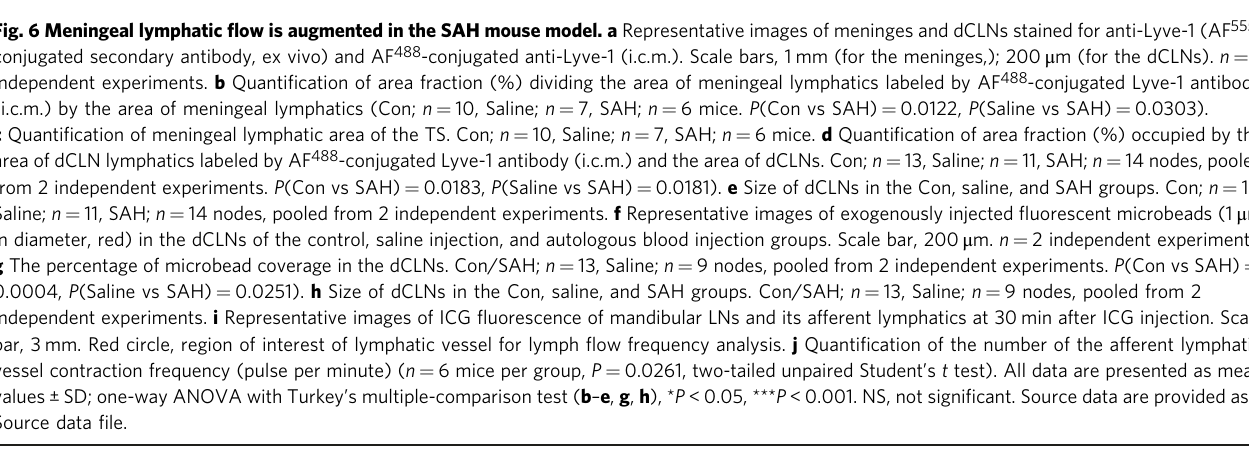
Fig. 6 Meningeal lymphatic fl ow is augmented in the SAH mouse model. a Representative images of meninges and dCLNs stained for anti-Lyve-1 (AF 555 - conjugated secondary antibody, ex vivo) and AF 488 -conjugated anti-Lyve-1 (i.c.m.). Scale bars, 1 mm (for the meninges,); 200 μ m (for the dCLNs). n = 2 independent experiments. b Quanti fi cation of area fraction (%) dividing the area of meningeal lymphatics labeled by AF 488 -conjugated Lyve-1 antibody (i.c.m.) by the area of meningeal lymphatics (Con; n = 10, Saline; n = 7, SAH; n = 6 mice. P (Con vs SAH) = 0.0122, P (Saline vs SAH) = 0.0303). c Quanti fi cation of meningeal lymphatic area of the TS. Con; n = 10, Saline; n = 7, SAH; n = 6 mice. d Quanti fi cation of area fraction (%) occupied by